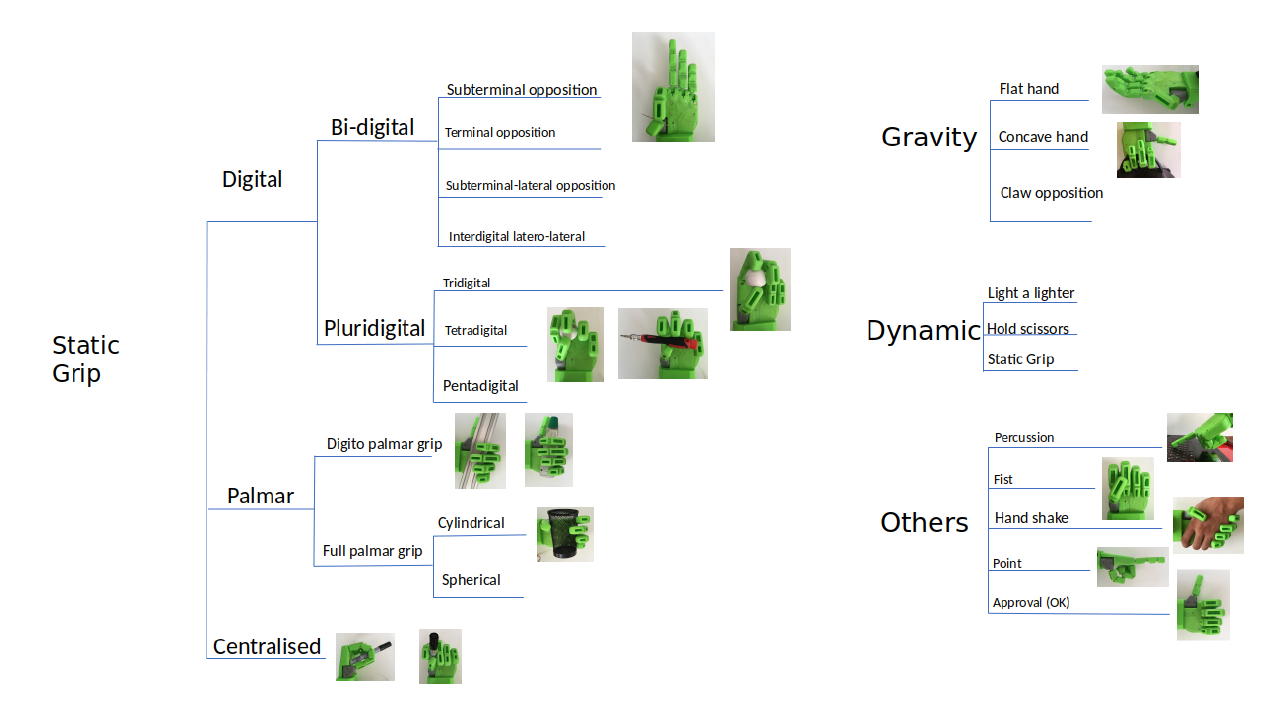
Figure 17. Summary of the attainable and unattainable grips of the